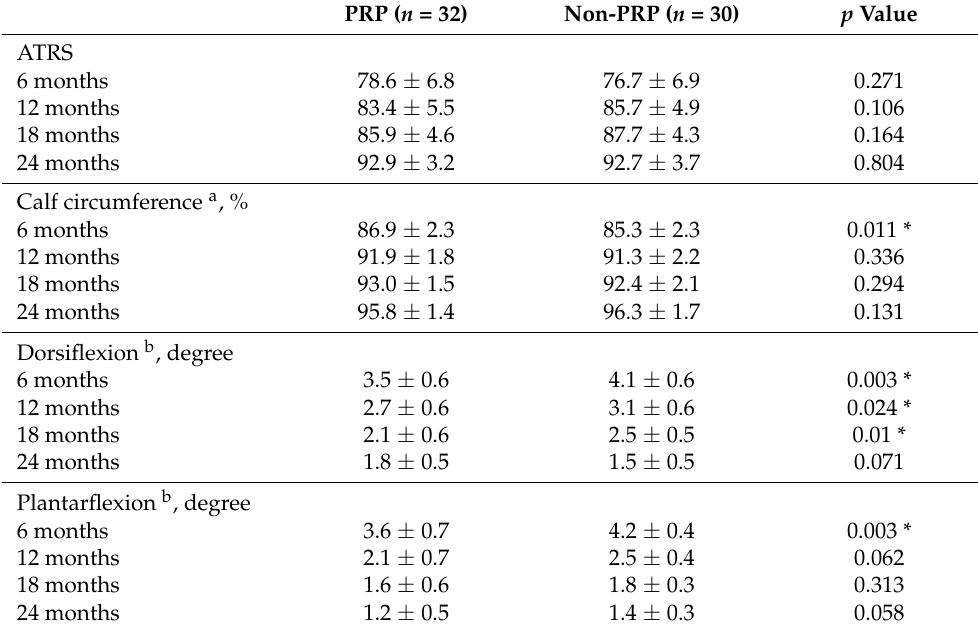
Table 3. Functional tests and scores for patients with repaired Achilles